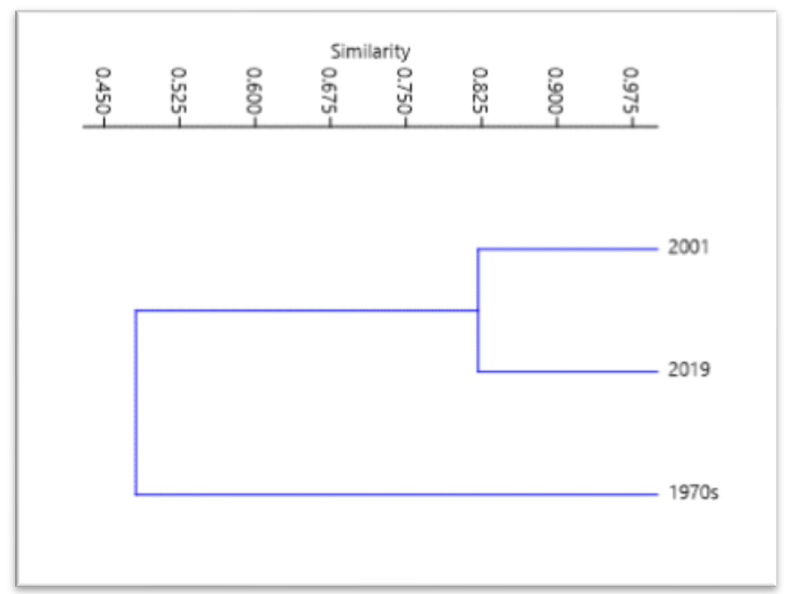
Figure 8. Dendrogram, calculated based on the Bray–Curtis similarity matrix, depicting mutual floristic similarities of the coralligenous floras investigated.